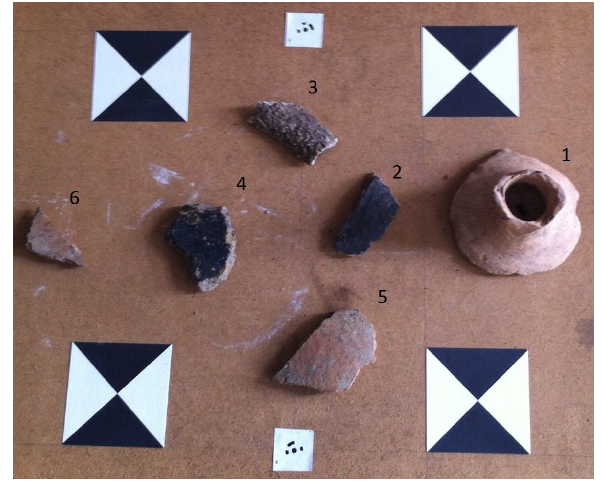
Figure 4. The set of fragments of archaeological